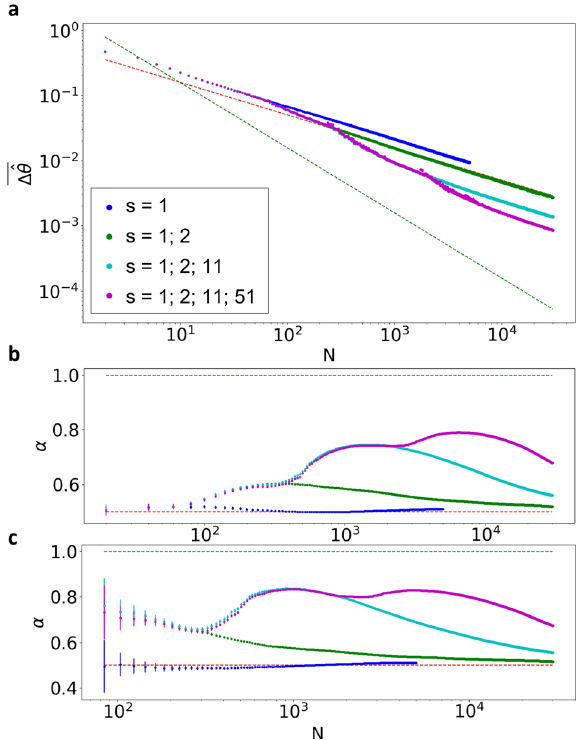
Fig. 3 Experimental sensitivity and its scaling with higher-order OAM states. a Averaged measurement uncertainty over R = 200 repetitions of the algorithm and over 17 different angle measure- ments, in the interval [0, π ), as a function of the total amount of resources N . The adoption of single-photon states with progressively higher-order total angular momentum allows to reach sub-SQL performance, progressively approaching the same power law of Heisenberg scaling. The red dashed line is the standard quantum ffiffiffiffi p Þ , while the green dashed line is the HL N limit for this system 1 = ð 2 π /(2 N ). b Value of the coef fi cient α and its standard deviation obtained by fi tting the points from N = 2 to the value reported on the x -axis with the curve C / N α . c Value of the coef fi cient α and its standard deviation obtained by fi tting the points from N = N 0 to the value reported on the x -axis with the curve C / N α . Purple points: estimation process with the full strategy. Blue points: estimation process by using only s = 1. Green points: estimation process by using only s = 1; 2. Cyan points: estimation by using only s = 1; 2;